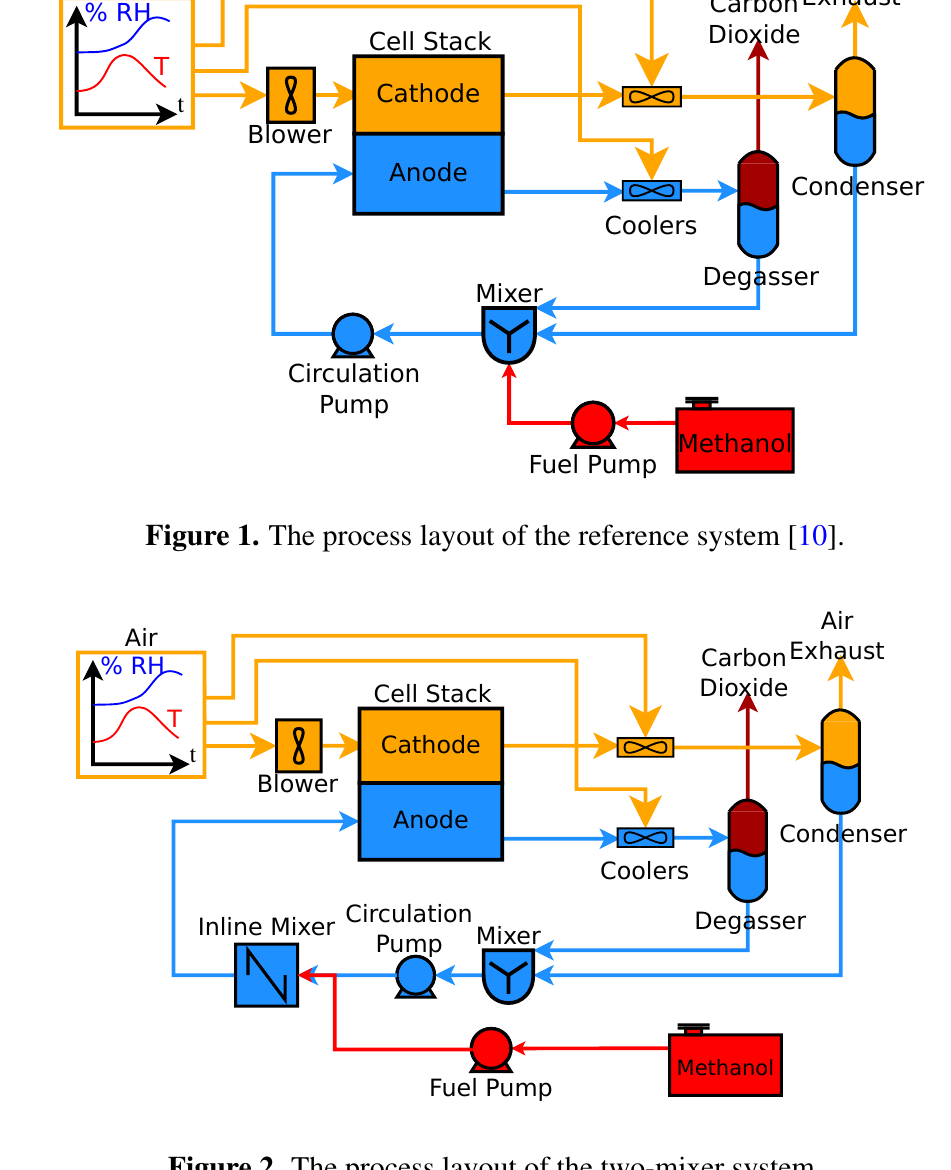
Figure 2. The process layout of the two-mixer